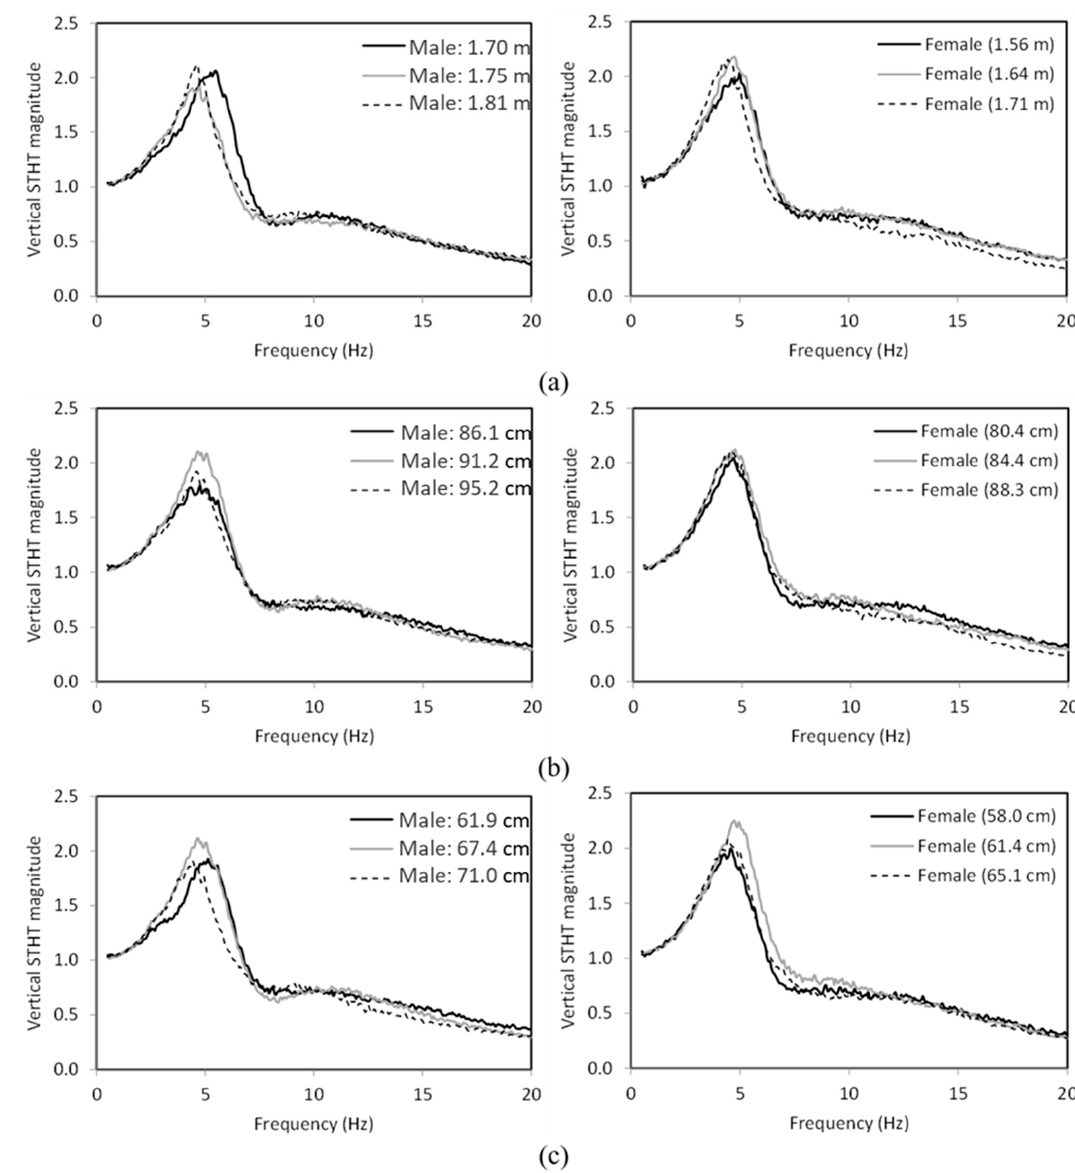
Figure 15. Effects of stature-related parameters on mean vertical STHT magnitude responses of male and female subjects: ( a ) stature; ( b ) sitting height; and ( c ) C7 height (NB support, 0.50 m/s 2 excita- tion).